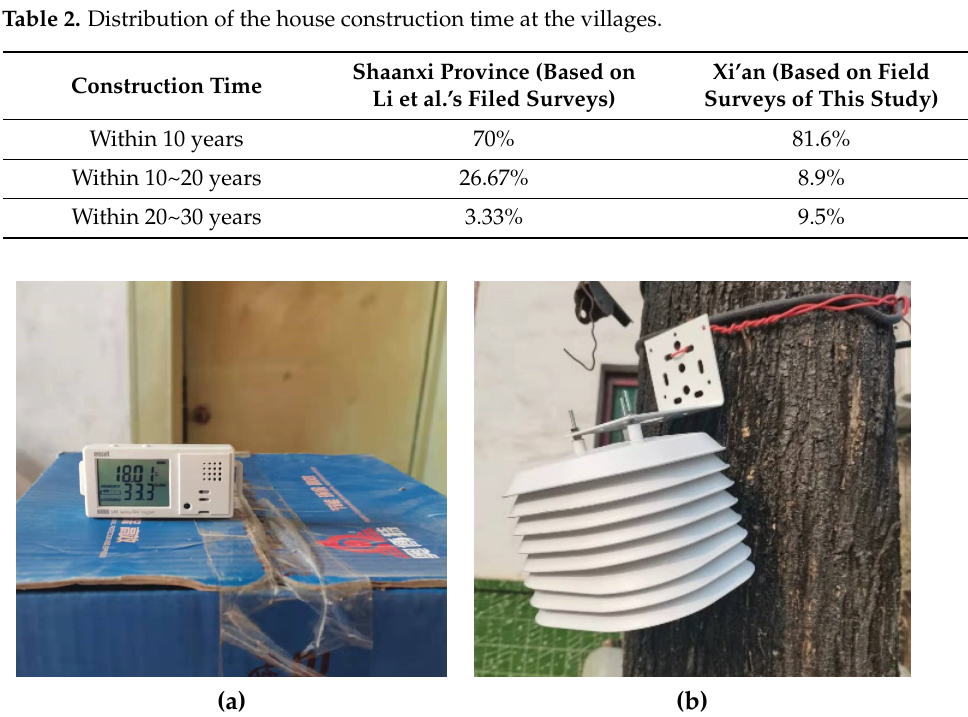
Table 2. Distribution of the house construction time at the villages.